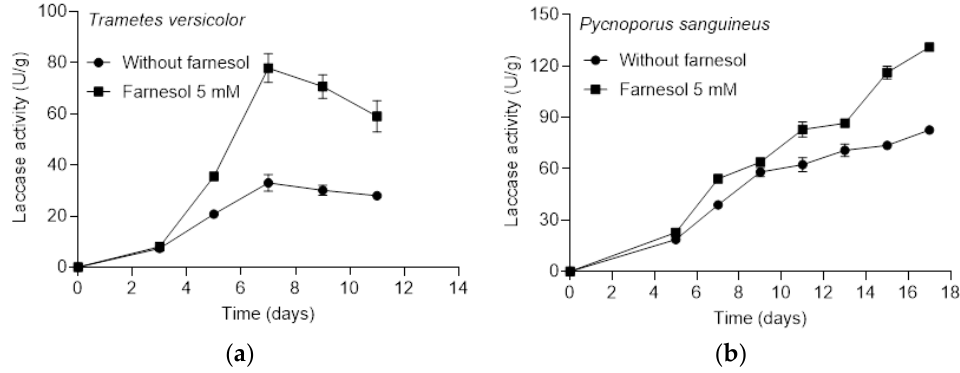
Figure 3. Time course of laccase production by T. versicolor ( a ) and P. sanguineus ( b ) grown on pineapple crown SSF supplemented with farnesol or not.